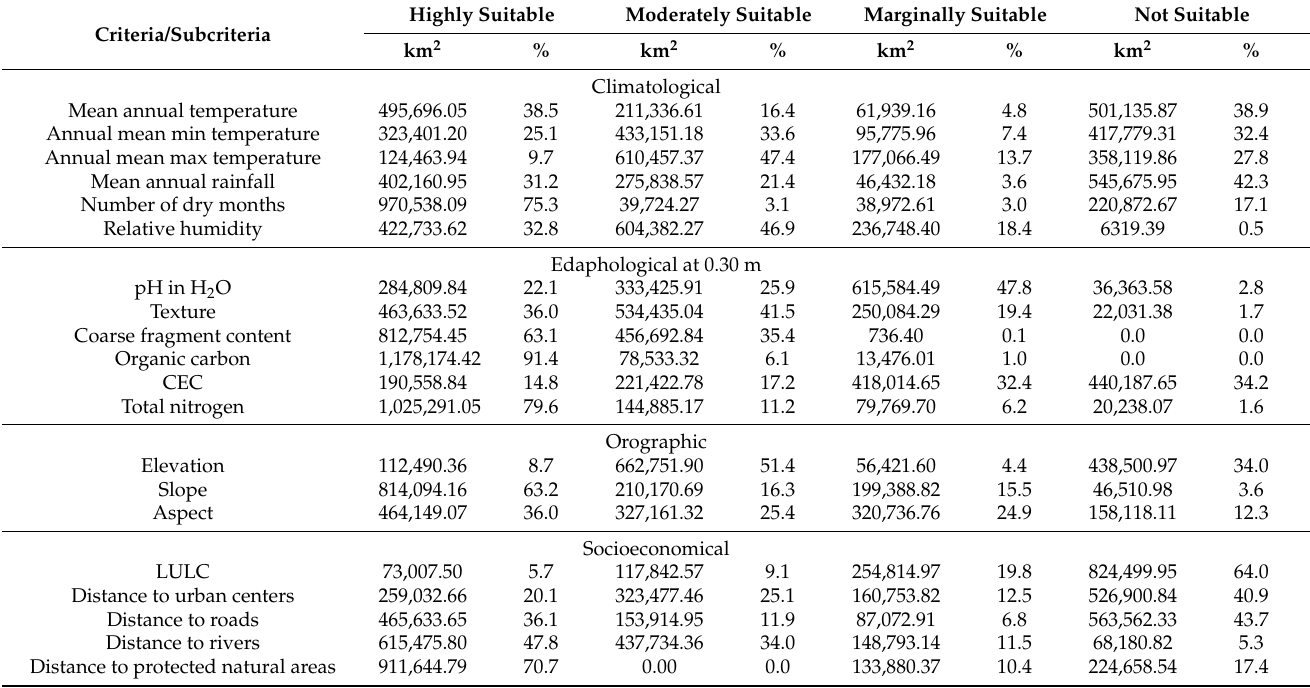
Table A1. Suitability area of subcriteria for cocoa cultivation in Peru, AHP model.